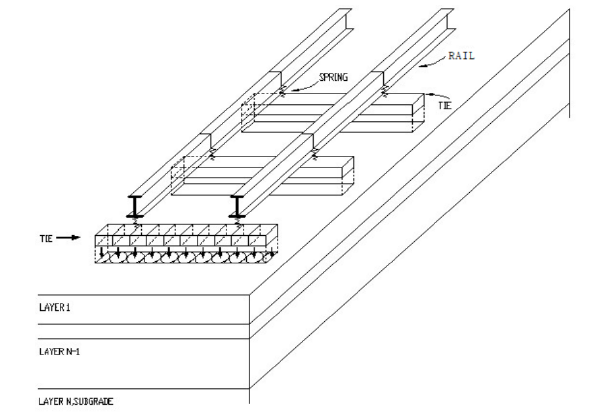
Figure 8: Trackbed model